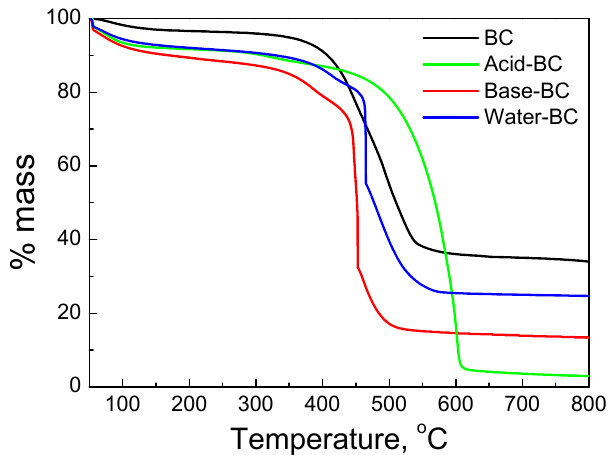
Figure 1. TGA curves of the studied biochars. The run was carried out under air atmosphere at 20 mL/min